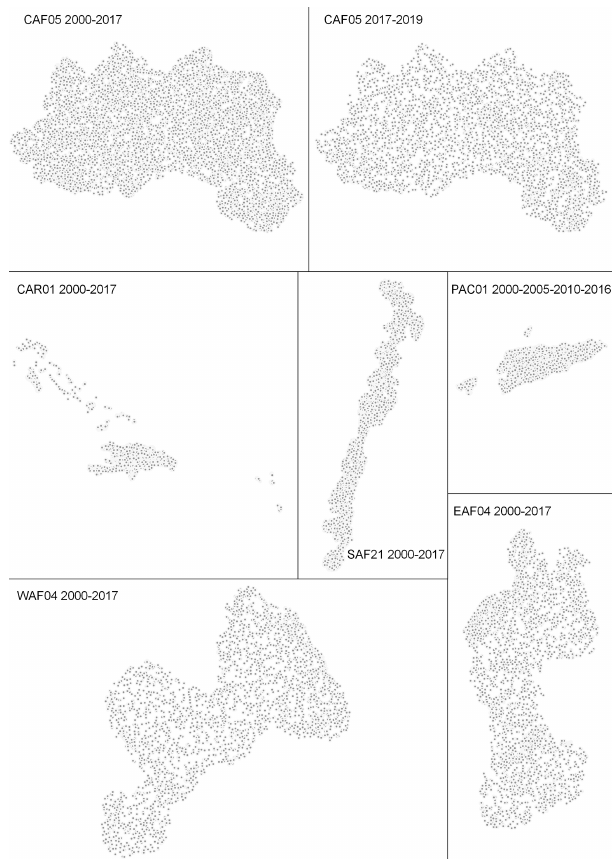
Table 4. Overall accuracies achieved for land cover mapping